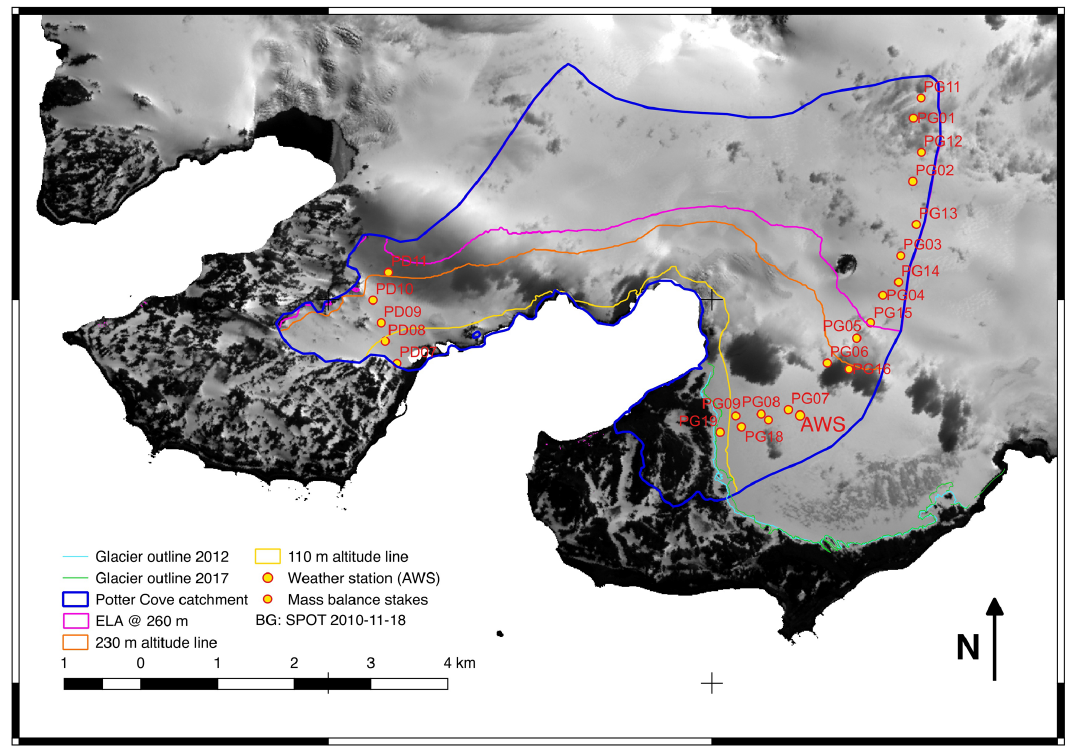
Figure 18. Glacier extent for equilibrium with actual climatic boundary conditions and an ELA of 260m (pink line) for the Potter Cove catchment on KGI, according to an AAR between 0.5 (yellow line) and 0.8 (orange line). The actual glacier extent is marked as green and light blue line and represents our own differential GPS measurements in austral summer 2012/13 and